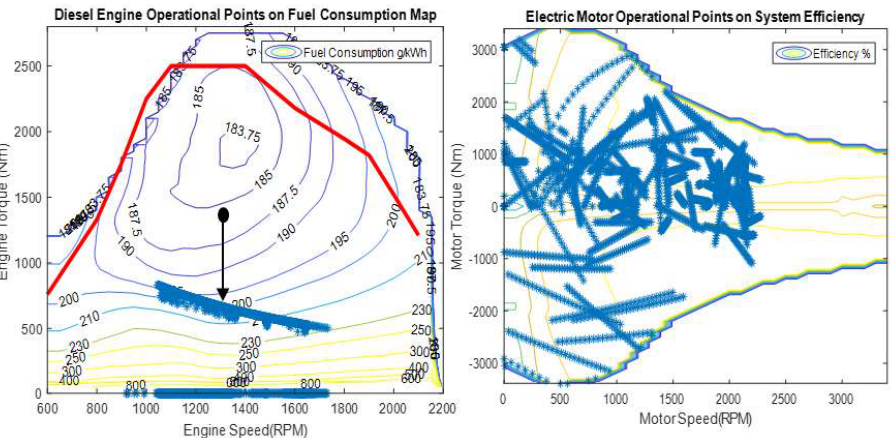
Figure 15. Engine power mid-point reduced and motor operational points from drive cycle 5 with TTRP hybrid power train and 236 kWh battery. * Operational point.